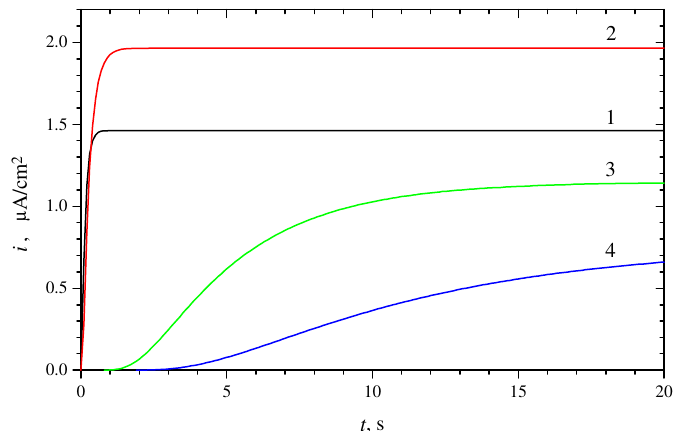
Figure 1 . The dynamics of the biosensor current i at the maximal enzymatic rate V max = 10 -7